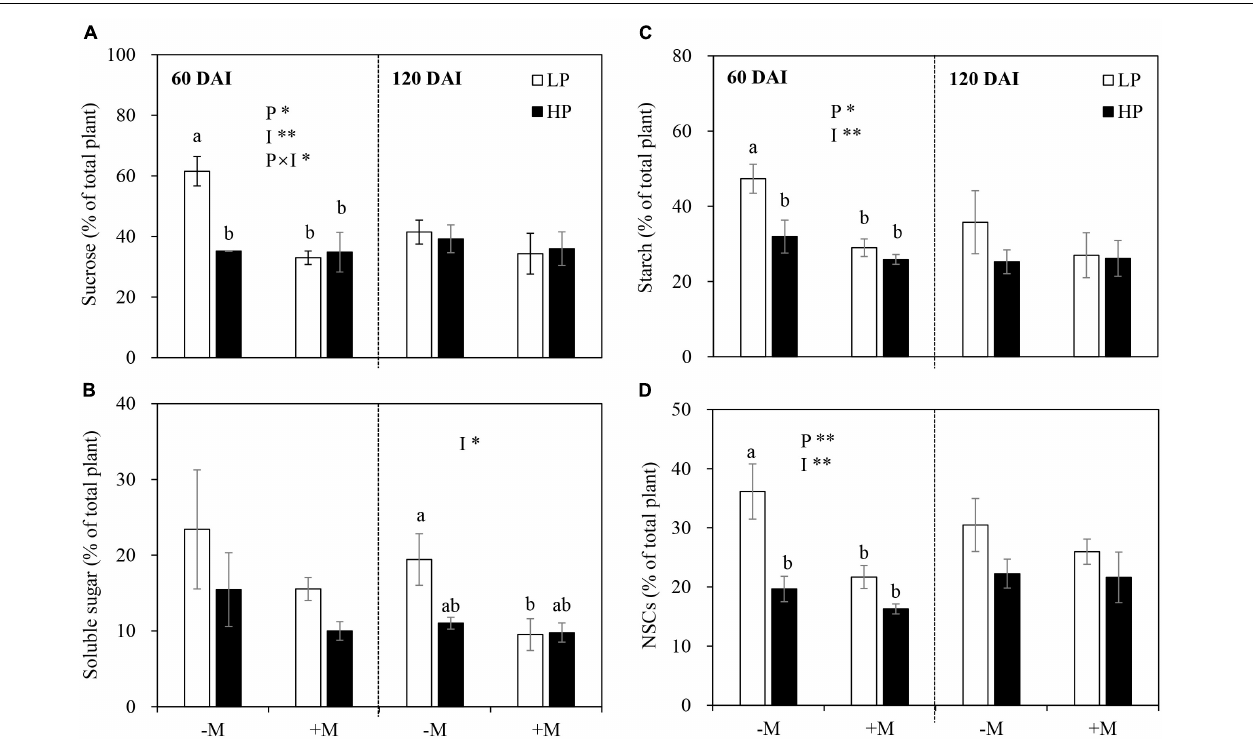
FIGURE 4 | (A) Percentage proportion of sucrose, (B) soluble sugar, (C) starch, and (D) total non-structural NSCs [allocation to roots as affected by soil P levels (P) and mycorrhizal status (I)] 60 and 120 days after inoculation (DAI). –M and +M represent non-AM and AM inoculation with R. irregularis , respectively. LP and HP represent 30 and 170 mg kg − 1 P application, respectively. Data are presented as mean ± standard error (SE, n = 3). Treatment effects were tested by two-way ANOVA separately between the two harvests. Only significant effects by ANOVA are displayed. ∗ P < 0.05; ∗∗ P < 0.01. Multi-comparison was performed across all treatments at the same harvest time, and the same letter indicates no significant difference between the means at P < 0.05 by Turkey’s HSD